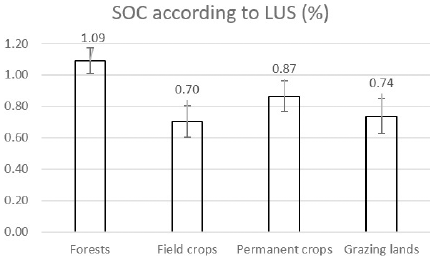
Figure 4. SOC contents according to land use systems in the Wadi Beja watershed, Tunisia.